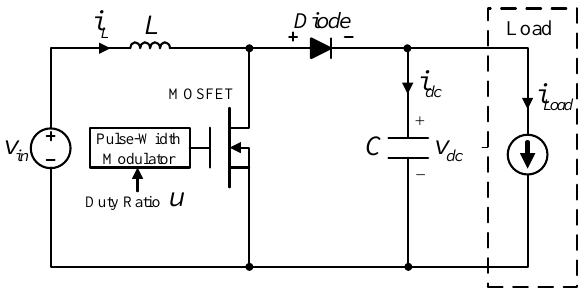
Figure 1. DC/DC boost converter